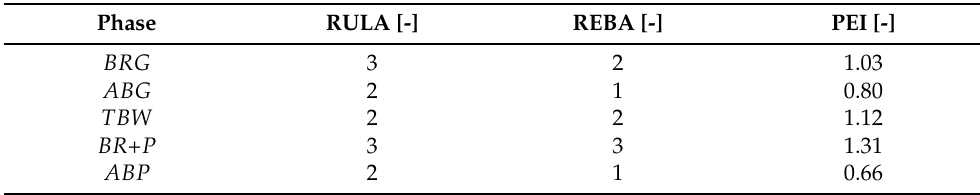
Table 2. RULA, REBA, and PEI scores for each phase of the task. Notice that in this assessment the phases BR and P are merged.